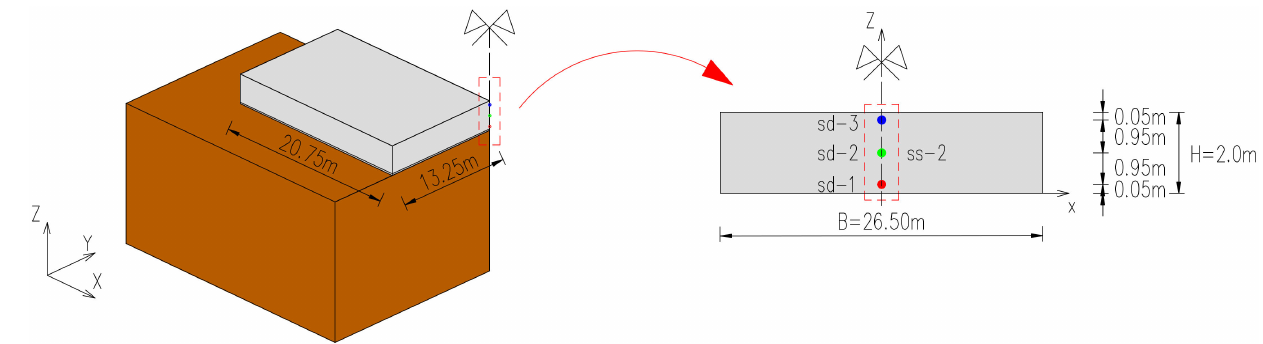
Figure 1. Thelocationsofsensorsintheslab: